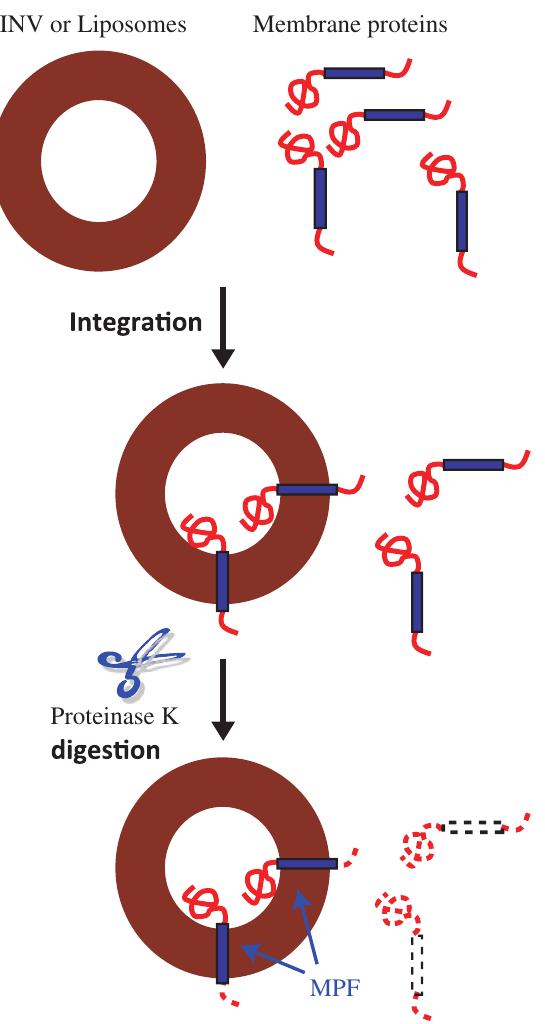
Figure 2 The in vitro assay system for protein integration into INV or